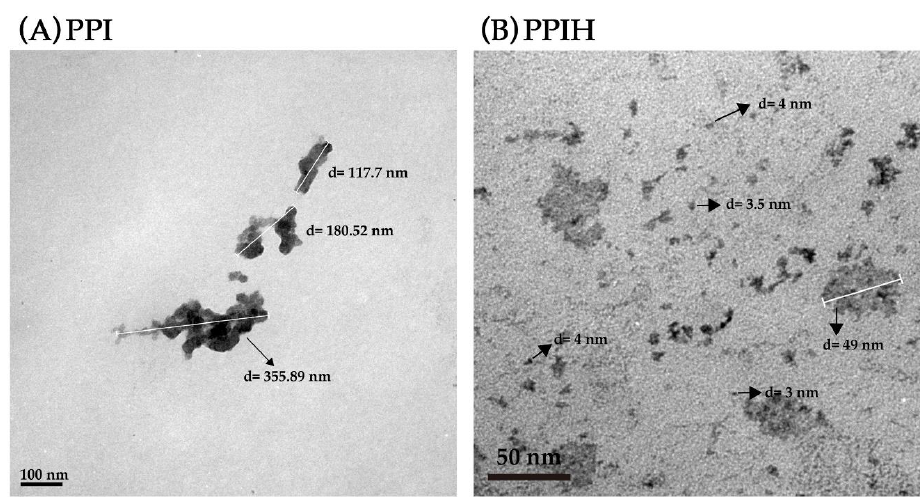
Figure 3. TEM analysis of PPI ( A ) and PPIH ( B ).